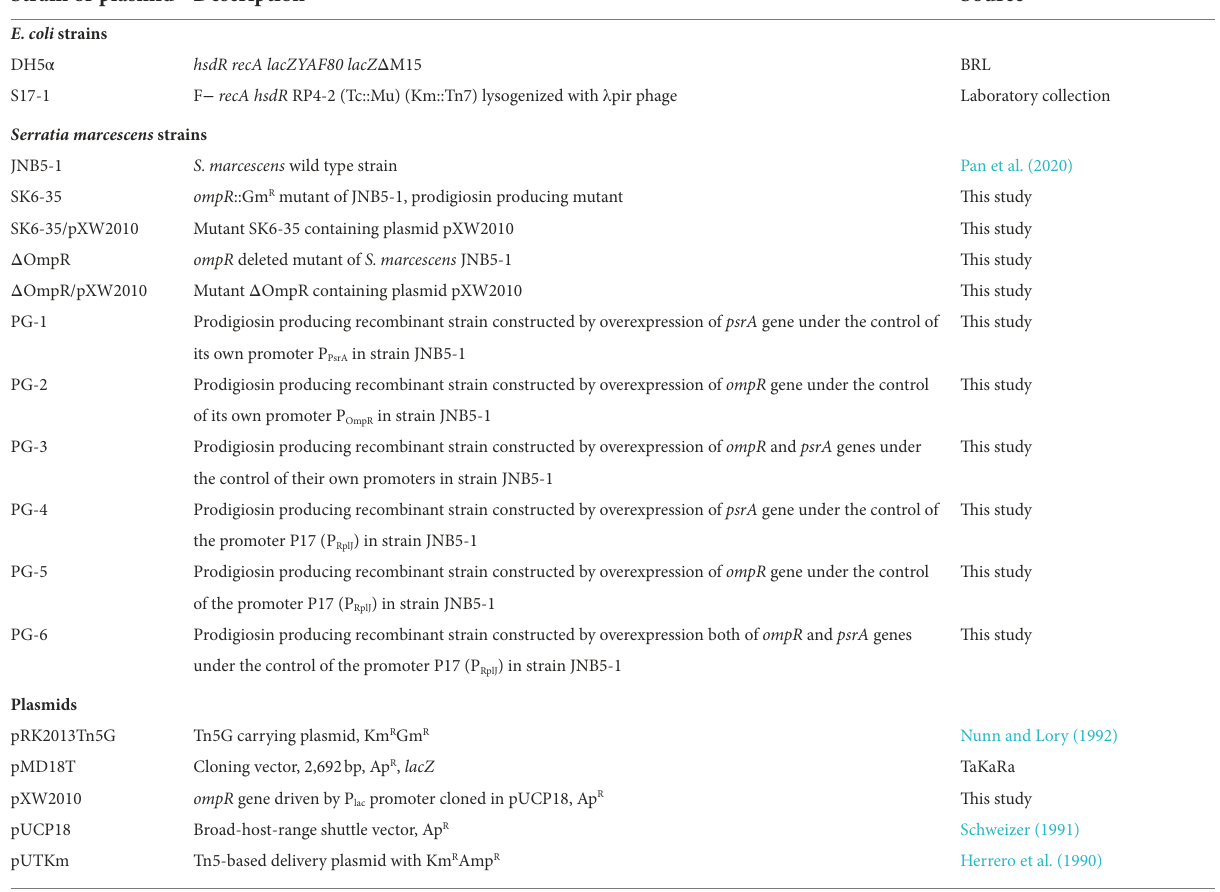
TABLE 1 Strains and plasmids used in this